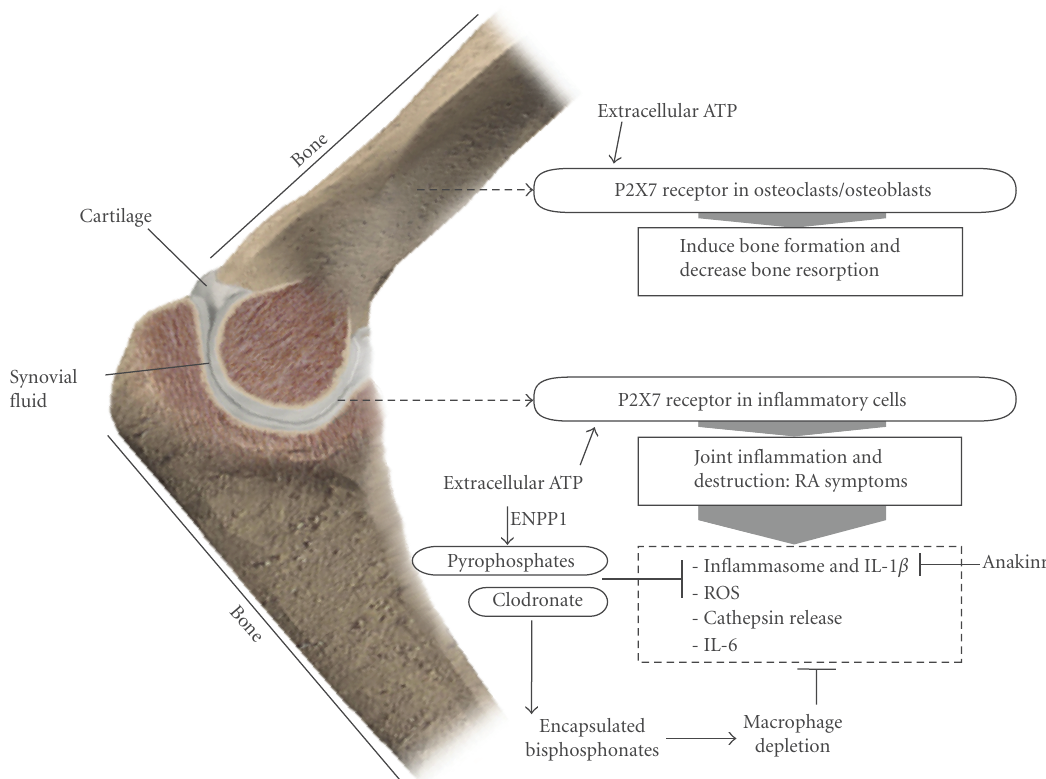
Figure 2: Role of extracellular ATP and P2X7 receptor in bone physiology and cartilage